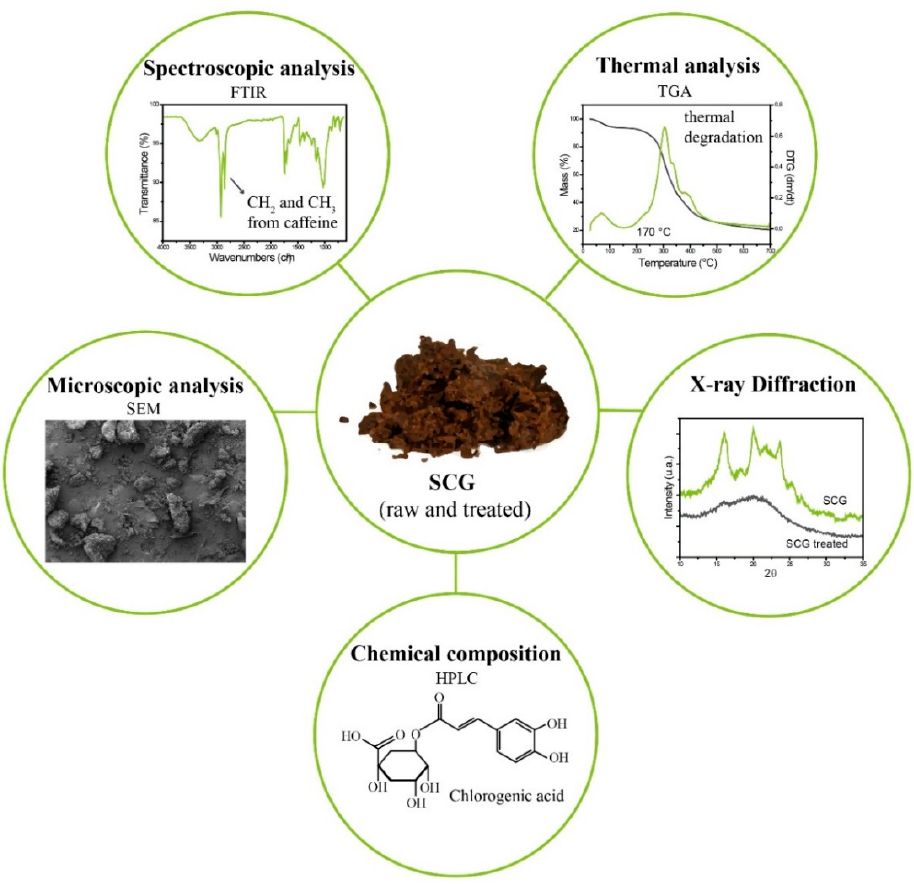
Figure 2. Typical SCG characterization techniques.